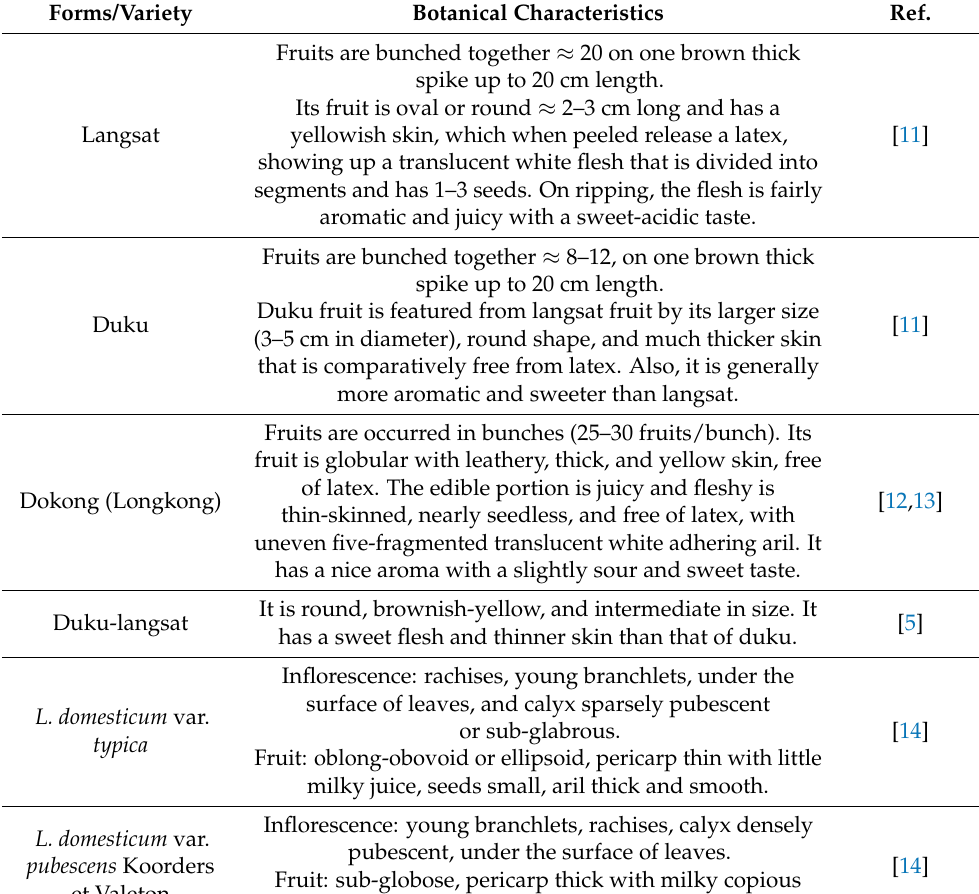
Table 1. Characteristics of the major distinct forms and varieties of L. domesticum